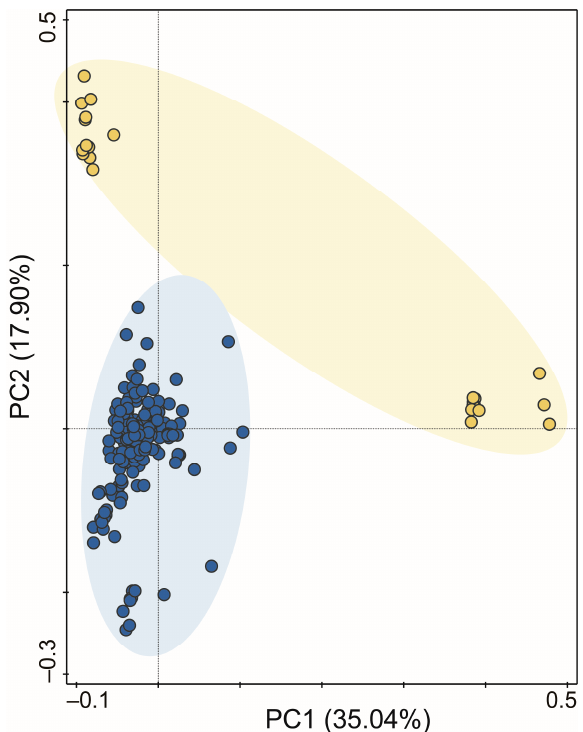
Figure 3. Graph of principal components one and two of the 242 wild soybean samples based on agronomic traits. Two groups are revealed, with 206 samples (blue dots) in Group I and 36 (yellow dots) in Group II, respectively. Table 6. Factor loadings (principle component one (PC1), PC2, and PC3) of the principal compo- nent analysis, based on the agronomic traits in 242 wild soybean samples, based on the mean data in the years of 2012 and 2013.